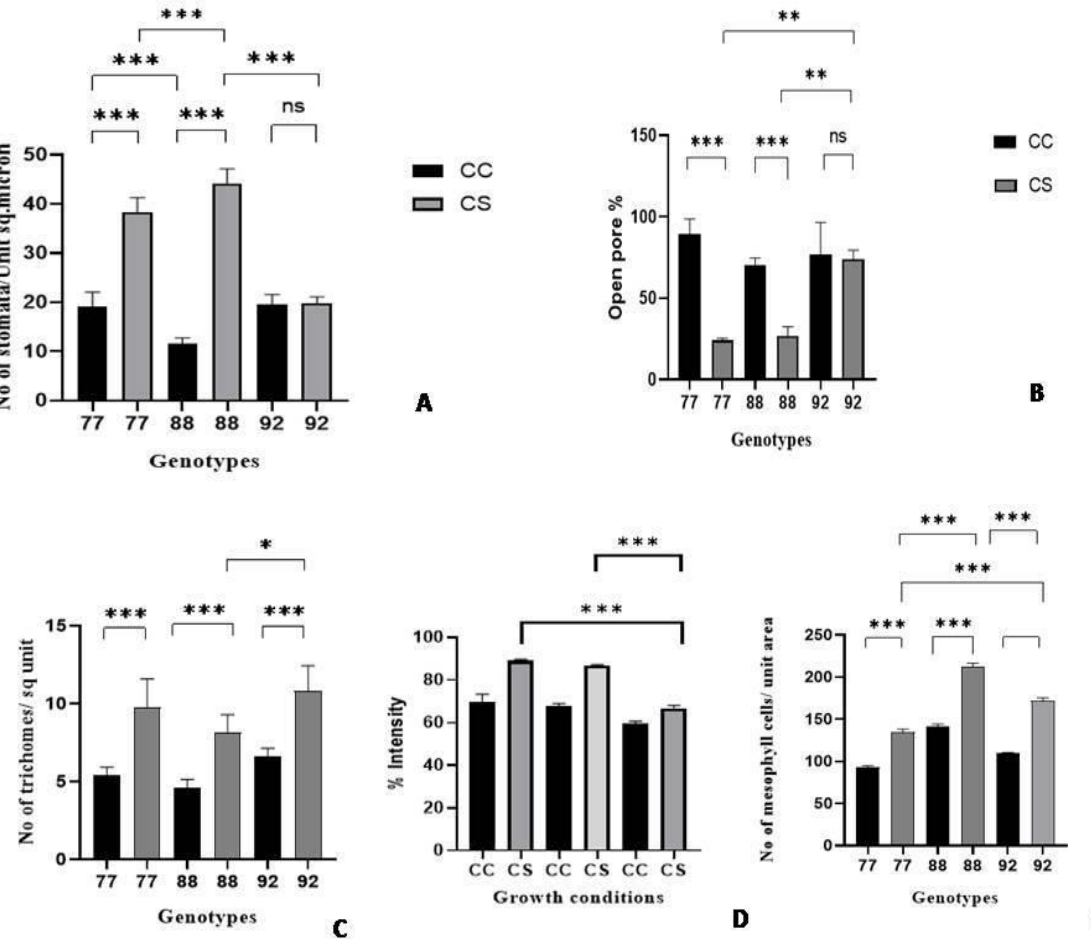
Figure 6. Microscopic analysis of stomata and trichomes in response to cold stress in selected V. radiata genotypes. stomatal density ( A ), stomata open pore percentage ( B ), trichome density ( C ), Autofluorescence analysis ( D ) Number of mesophyll cells per unit area ( E ) in the selected genotypes (G77) PAU911, (G88) PUSA1672 and (G92) PUSA 9531) of Vigna radiata grown under cold stress at 10 ◦ C (CS) and control condition 22 ◦ C (CC). All the data are analyzed on the basis of one-way ANOVA. * p < 0.01, ** p < 0.001, *** p < 0.0001.